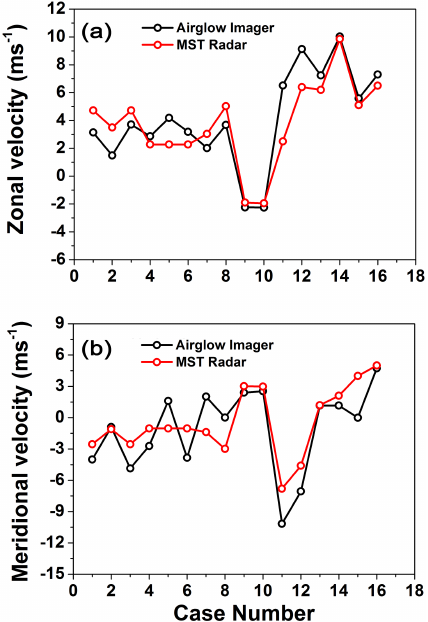
Figure 7. Comparison of (a) zonal and (b) meridional wind veloci- ties derived by airglow imager and MST